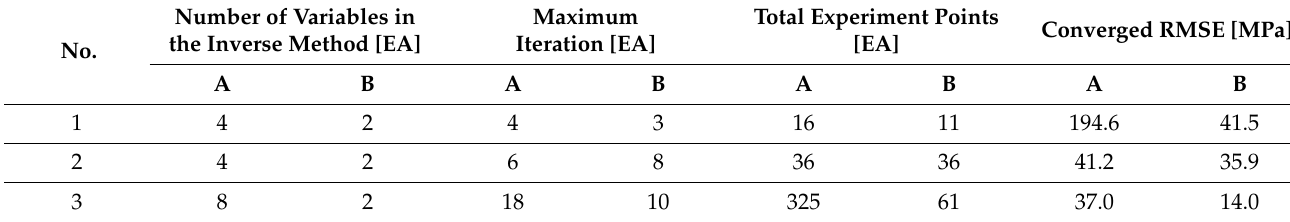
Table 5. Results of specification in inverse method (A: Typical method, B: Proposed